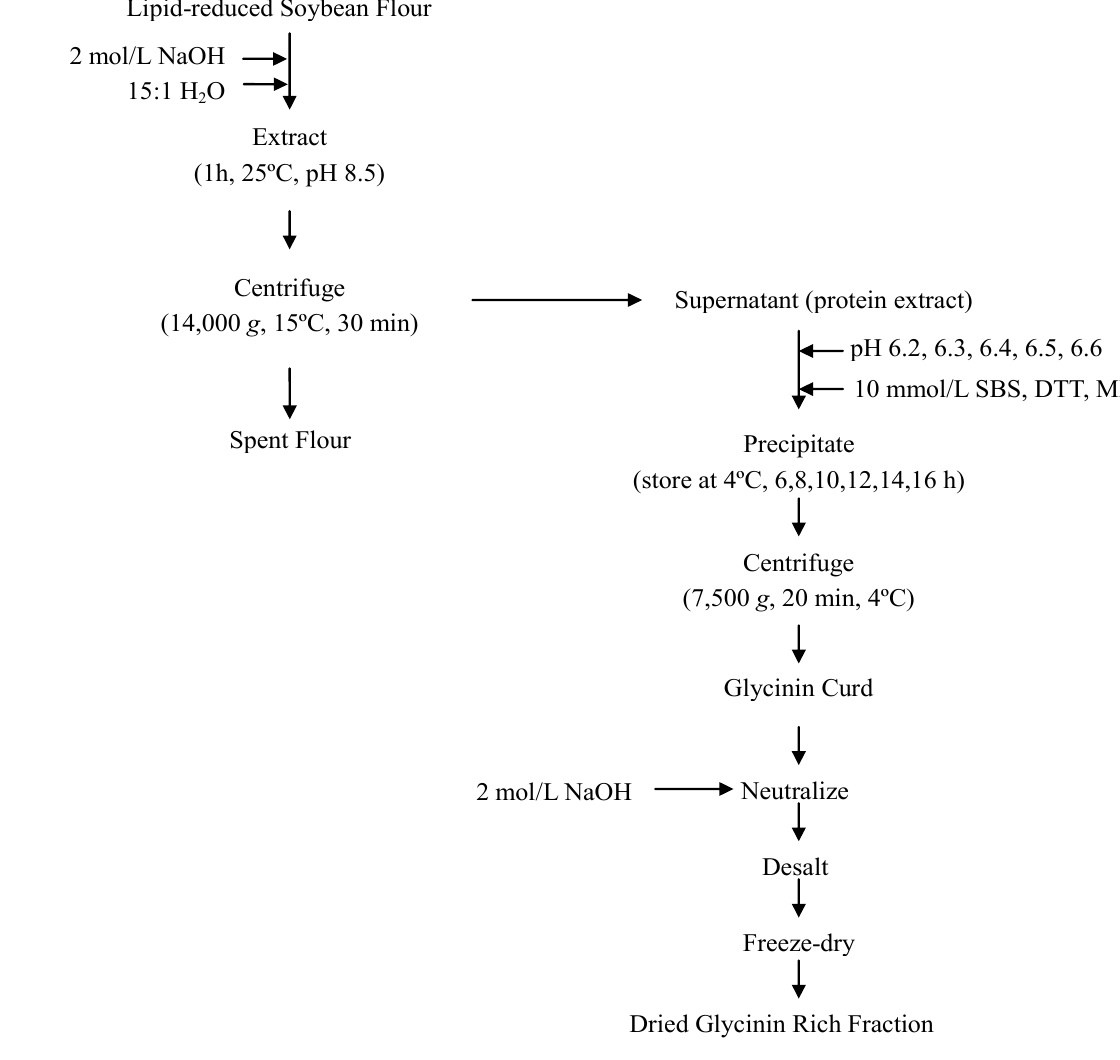
Figure 5. Flow diagram for the procedure of fractionating soybean glycinin (11S). Lipid-reduced Soybean